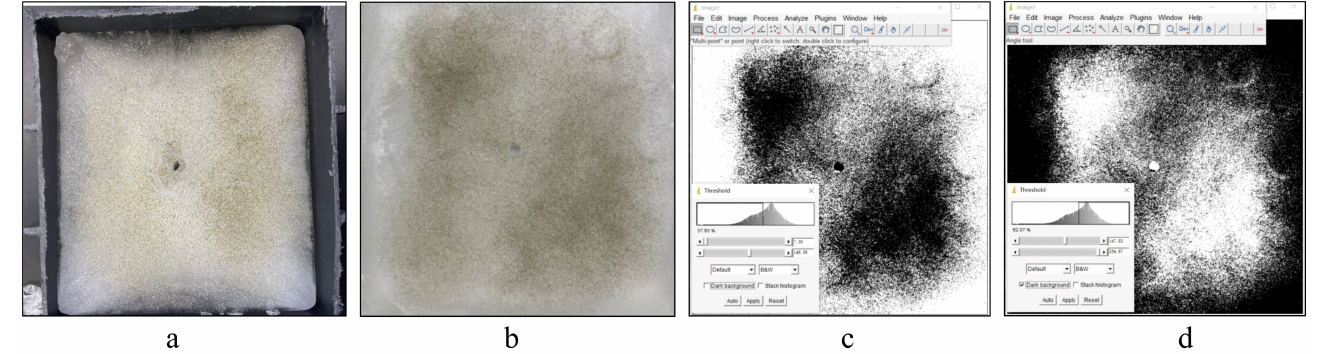
Figure 4. Mineral dust collected on-site in the study area ( a ); mineral dust of different particle sizes after sieving by standard sieves ( b – d ).